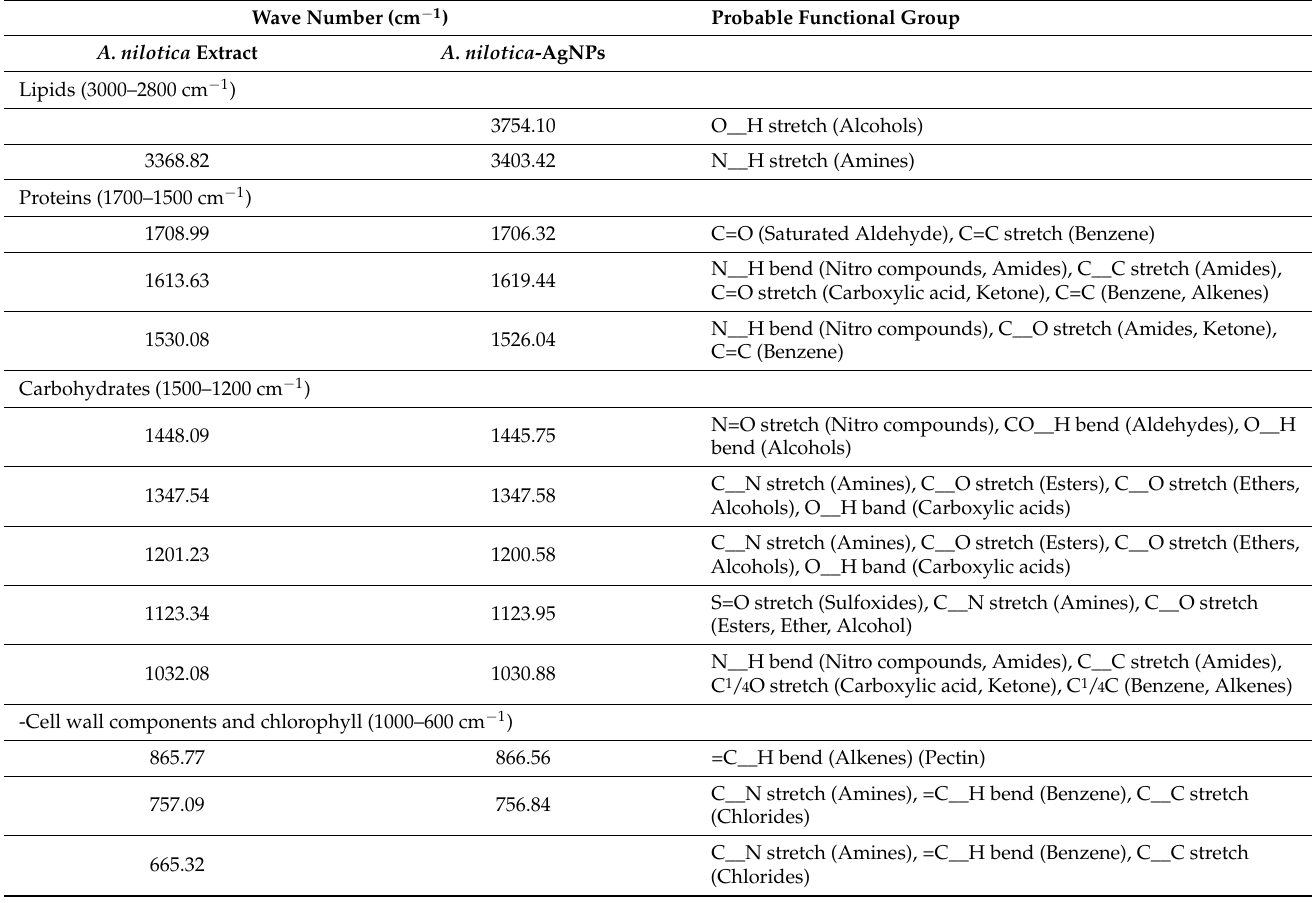
Table 2. FT-IR spectra showing probable functional groups of aqueous A. nilotica pod extract and A. nilotica -AgNPs extract.